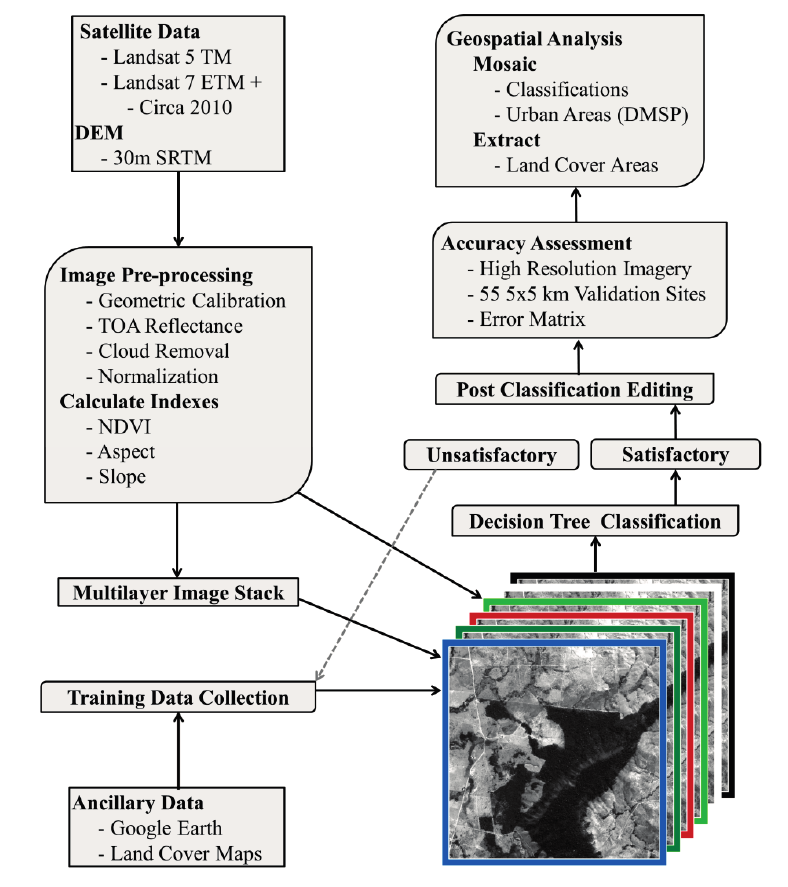
Figure 1. Schematic diagram of the methodology framework used to map land cover for South